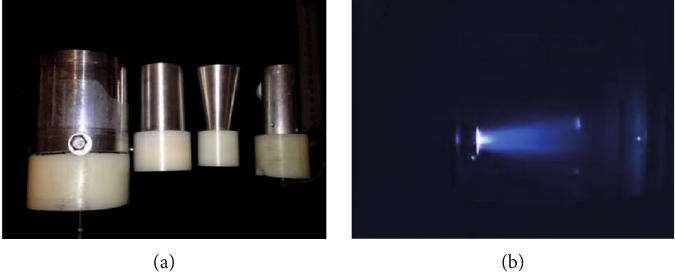
Figure 22: Johnson ’ s AB-PPT: (a) the four PPTs tested with di ff erent diameters; (b) 62J plume images at 50 μ Torr, 0-40 μ s after igniter discharge